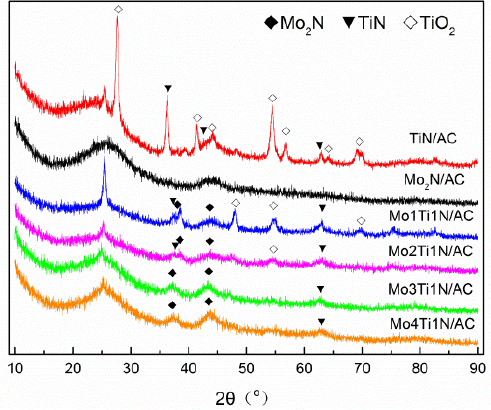
Figure 1. XRD patterns for six different catalysts.